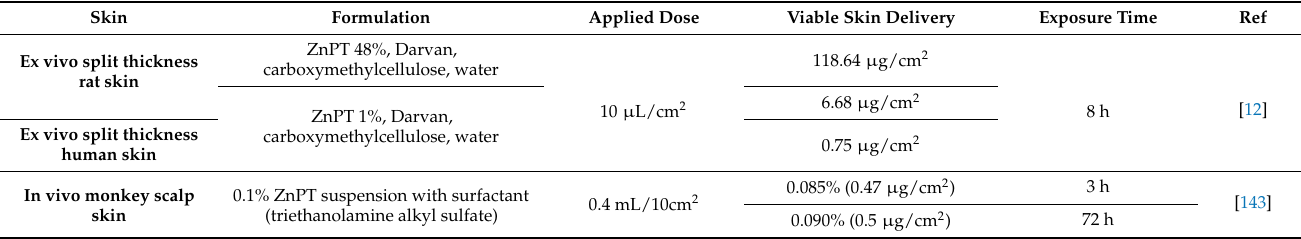
Table 3. Exposure of zinc pyrithione to viable